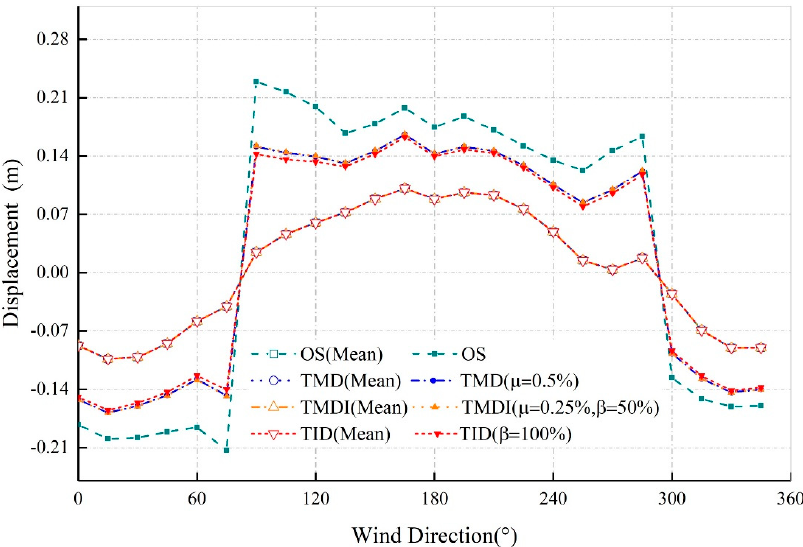
Figure 15. Mean and extreme top-floor displacement response at the x -axis corresponding to wind directions ranging from 0° to 345°.